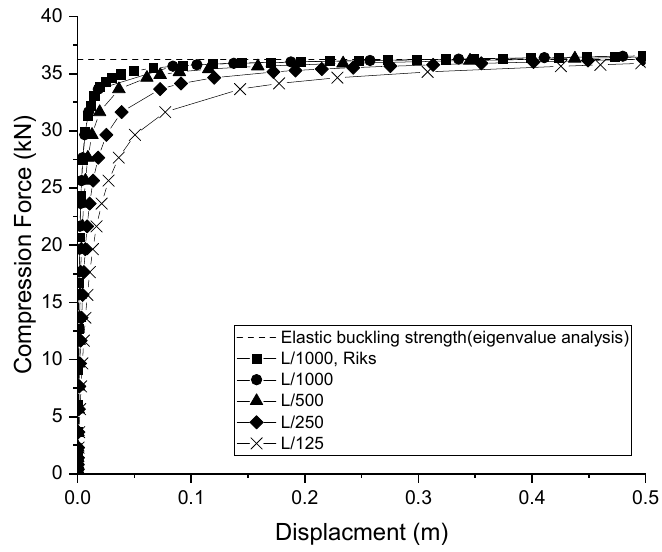
Figure 12. Load–displacement curve at loading point according to eccentricity.